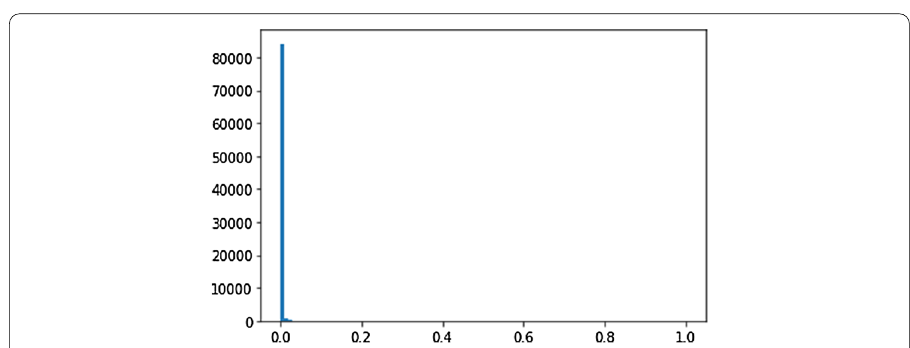
Fig. 7 PCA—Number of instances vs reconstruction error value for clean data points